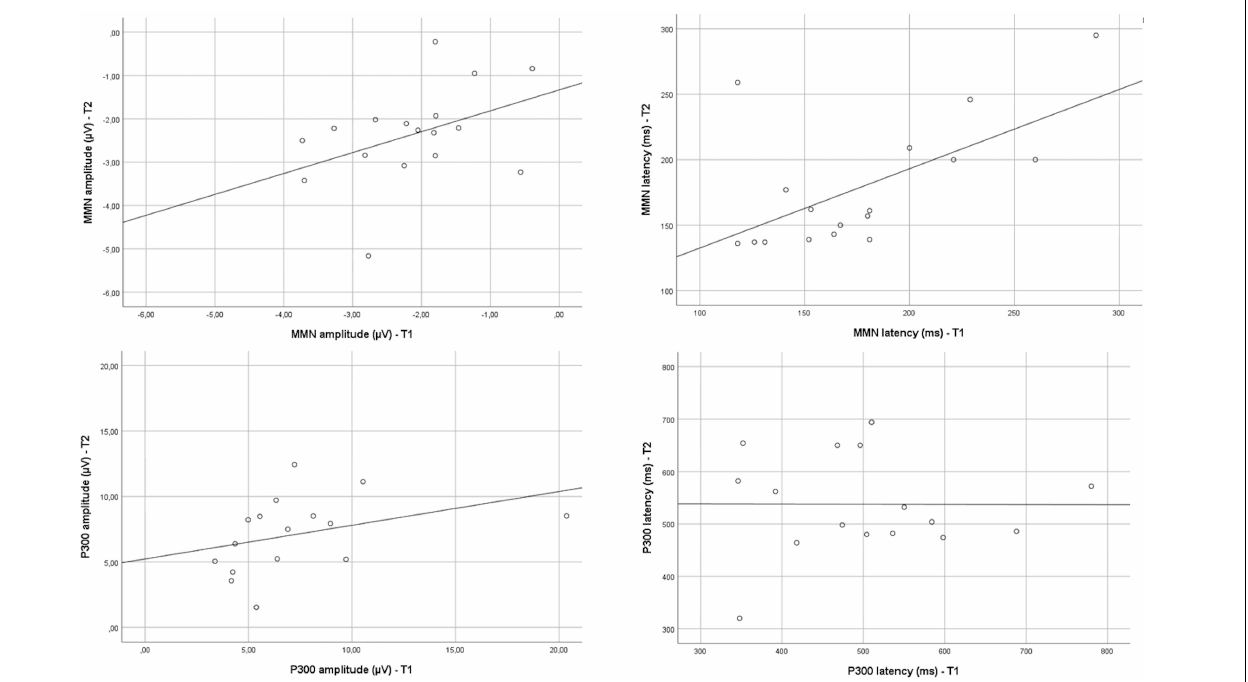
FIGURE 1 | Scatterplots of “the amplitude/latency – MMN/P300 at T1” versus “amplitude/latency – MMN/P300 at T2.”